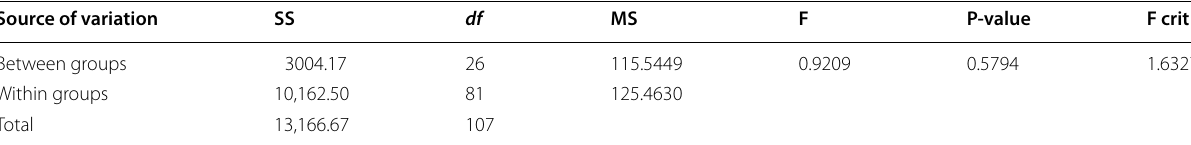
Table 4 Single-factor ANOVA on the percentage agreement of the items in the variable scale “Adequacy in energy efficiency” with α = 0.05